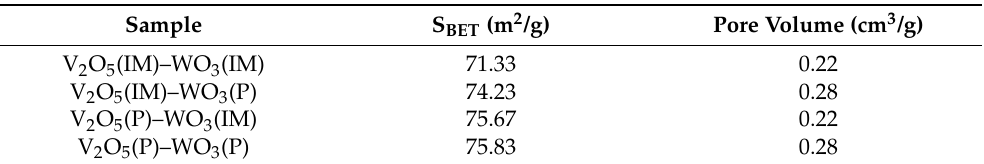
( a ) NH 3 -temperature-programmed desorption (NH 3 -TPD) profiles and ( b ) H 2 -temperature-programmed reduction (H 2 -TPR) profiles of V 2 O 5 (IM)–WO 3 (IM), V 2 O 5 (IM)–WO 3 (P), V 2 O 5 (P)–WO 3 (IM), and V 2 O 5 (P)–WO 3 (P). B and L indicate Bronsted and Lewis acid sites, respectively. Table 3. NH 3 -temperature-programmed desorption (NH 3 -TPD) and H 2 -temperature-programmed reduction (H 2 -TPR) integral intensity of V 2 O 5 (IM)–WO 3 (IM), V 2 O 5 (IM)–WO 3 (P), V 2 O 5 (P)–WO 3 (IM), and V 2 O 5 (P)–WO 3 (P).